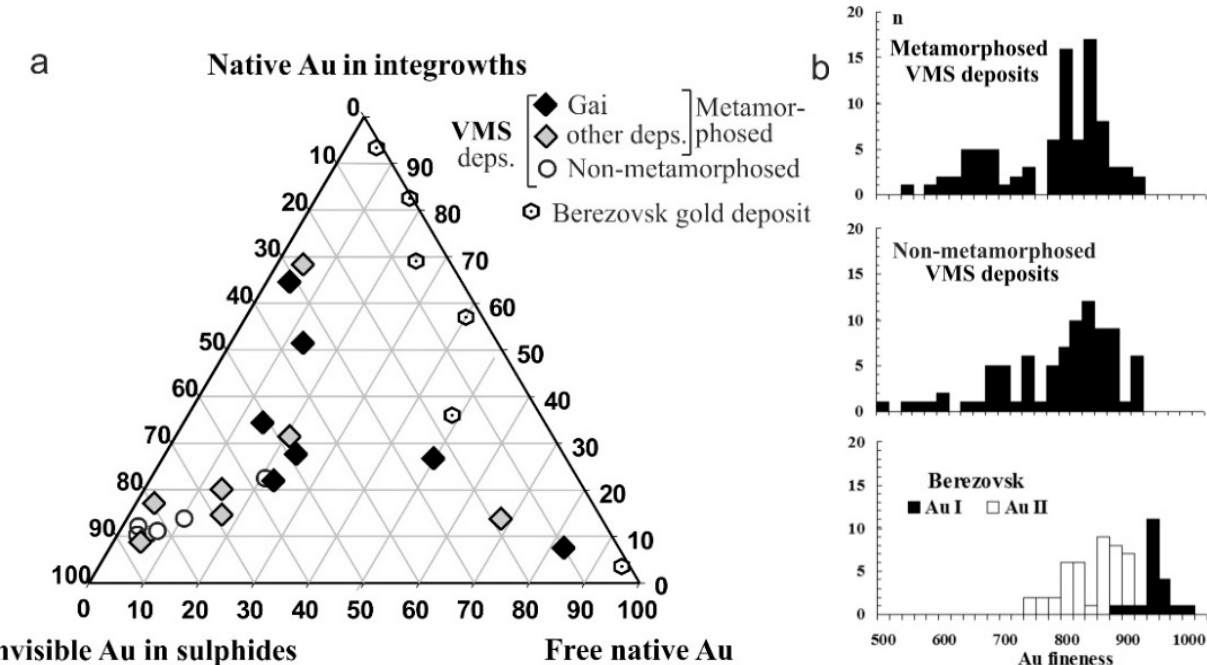
Figure 28. Gold in sulphide ores of the Berezovsk and VMS deposits of the Urals. ( a ) Gold occurrence forms in the ore, based on the results of step-by-step autoclave leaching of technological bulk probes; ( b ) gold fineness, microprobe data.